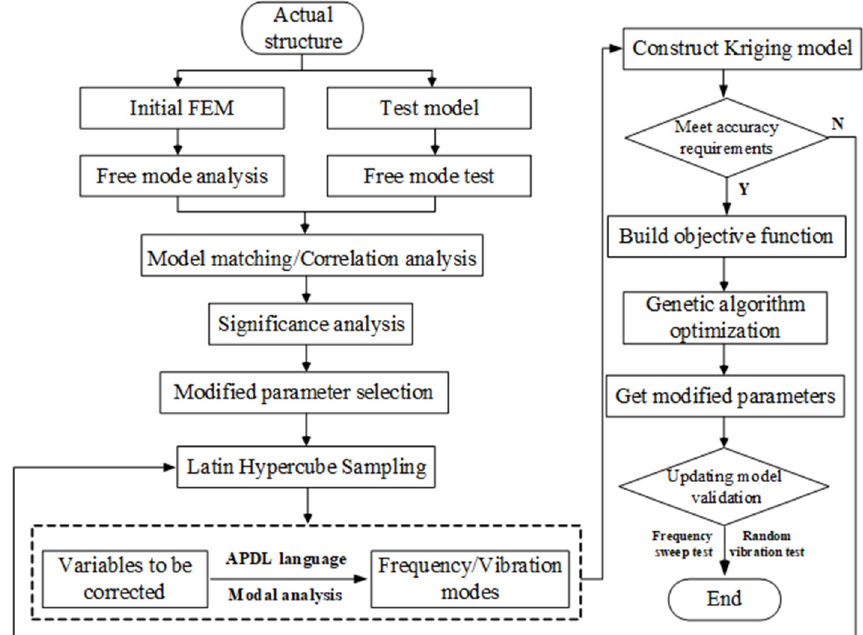
Figure 6. Flow chart of FEMU .